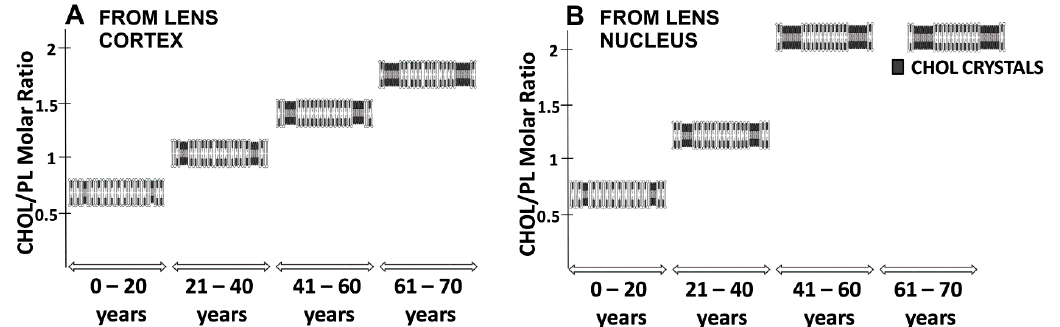
Figure 6. Schematic drawing presenting changes in the organization of cortical ( A ) and nuclear lens ( B ) lipid membranes as functions of age and cholesterol/phospholipid (CHOL/PL) molar ratio in lens membranes. Note that the cholesterol content and size of the CBDs change with age. Also, in the group of 61–70-year-old donors, some of the cholesterol in the nuclear fiber cells formed cholesterol crystals. The shading of domains indicates changes in CBDs size. Adapted from [23].